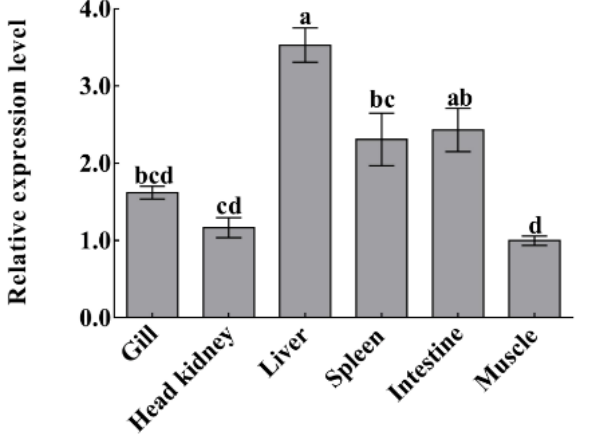
Figure 9. The mRNA expressions of Ci Df in various tissues from uninfected grass carp. Vertical bars represent the mean ± SD. The letters a–d represent significant differences among tissues ( p < 0.05).